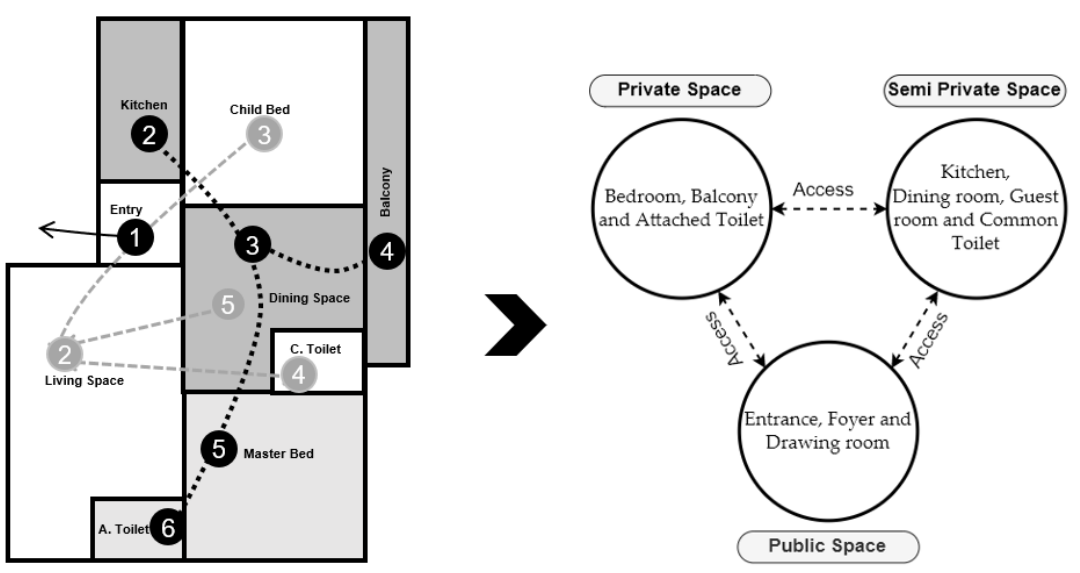
Figure 2. Circulation structure of middle-income domestic living scenarios in Dhaka, Bangladesh. (Source: author, from field observation).